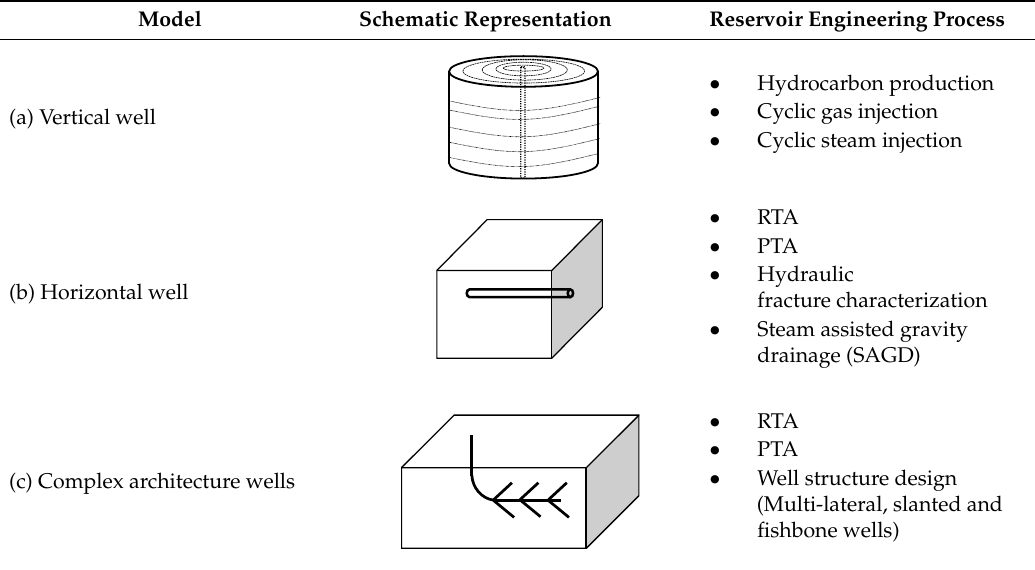
Table 3. Injection-pattern-scale models * .